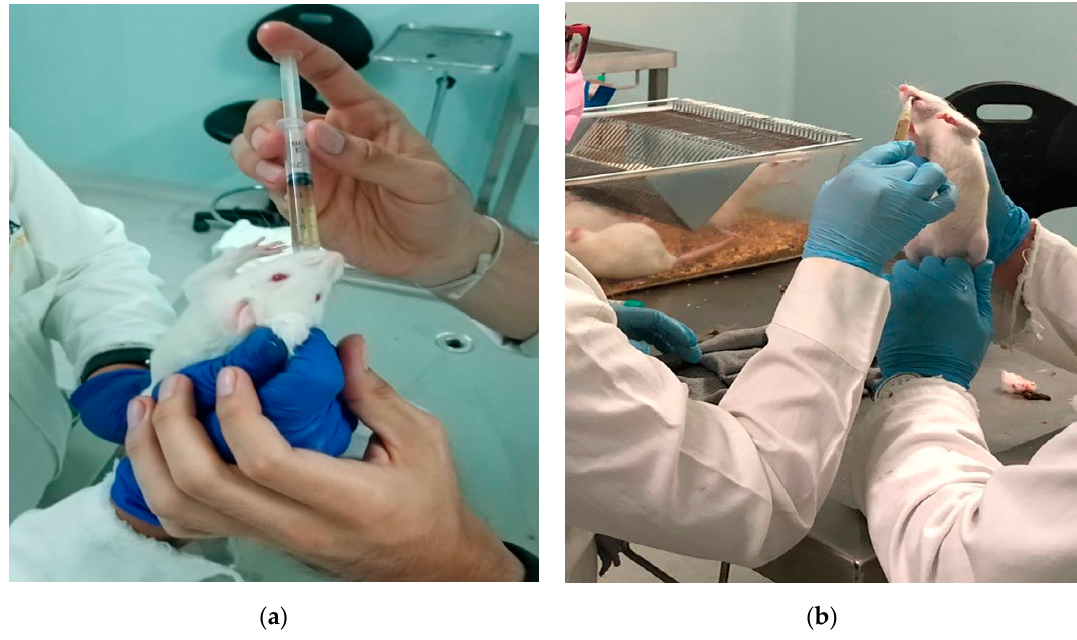
Figure 16. ( a ) Oral administration of glucose solution (1·g/mL). ( b ) Oral administration of MA/EA NPs suspension. 30 minutes